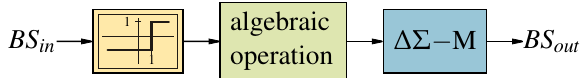
Figure 15. Fundamental algebraic operation Bipolar Interpretation.